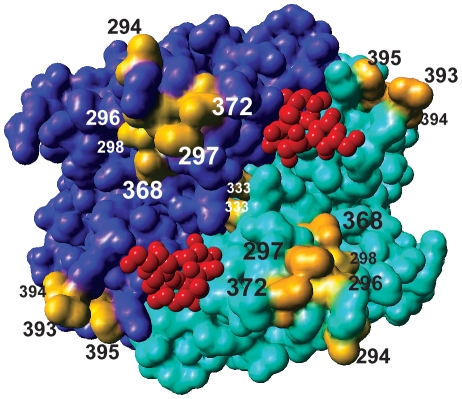
Sites identified by molecular adaptation analyses located on top of the GII.4 capsid dimer.Two parts of the dimer were given different shades of blue, the sites identified as under positive selection, co-evolving with other sites, or sites previously identified to be involved in host-interactions, were colored yellow. Ligands (B trisaccaride) bound in the binding pocket are shown in red. Protein structure 2OBT was used for generating this representation [53].